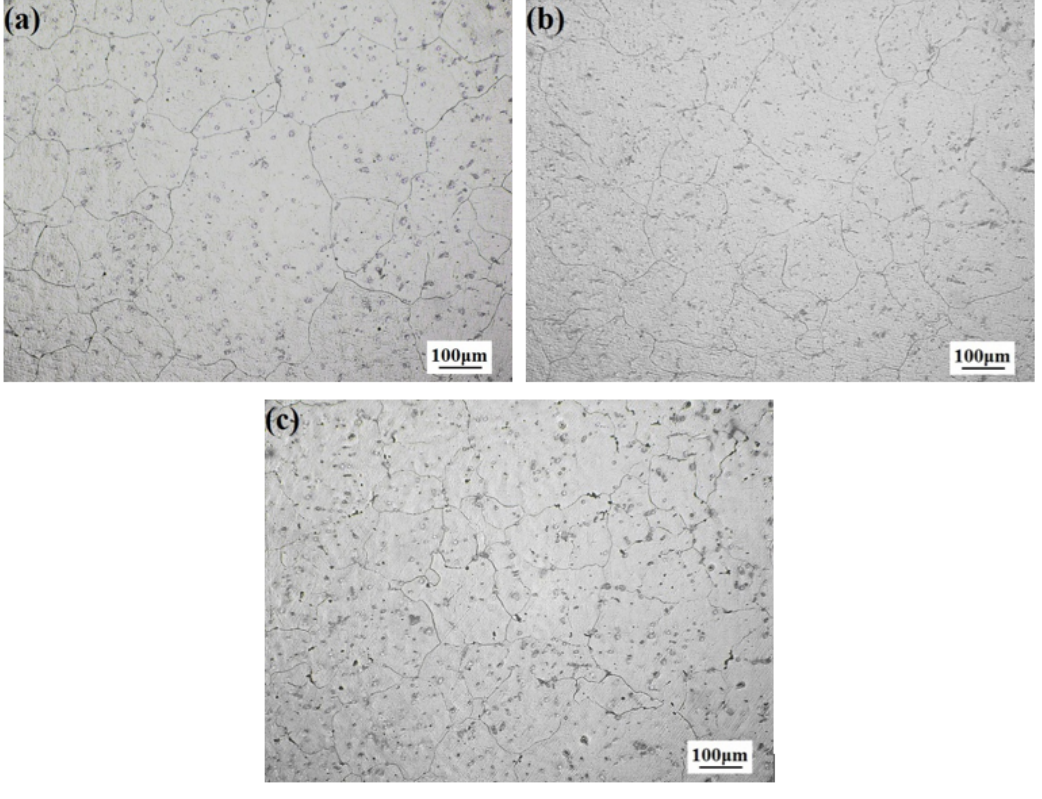
Figure 1. Optical microstructures of homogenization alloys. ( a ) AZ31; ( b ) AZ31 - 0.5%CaO; and, ( c ) AZ31 - 1%CaO.